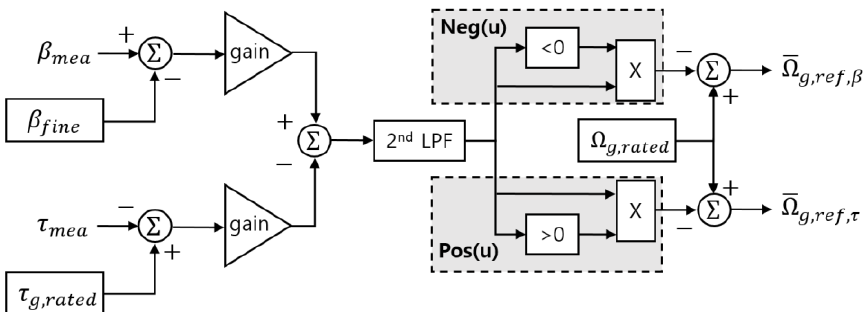
Figure 11. Block diagram of SPS algorithm for pitch and torque control loop.